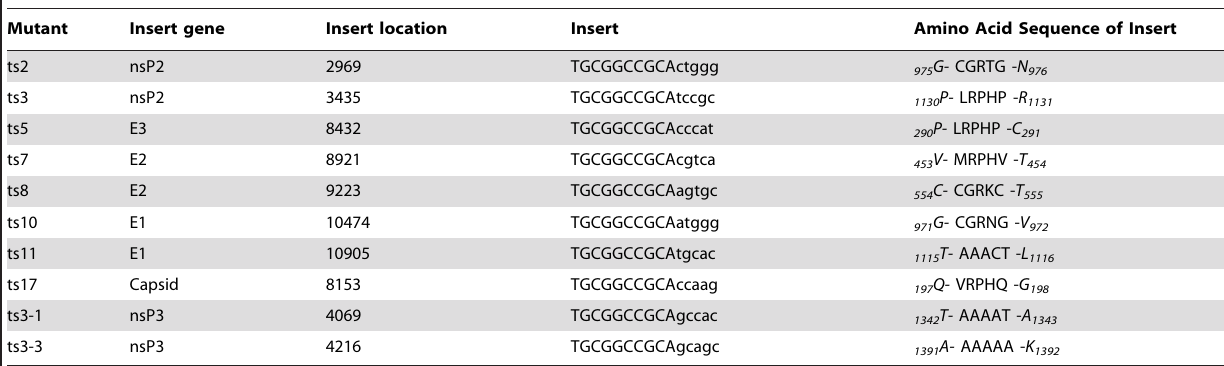
Table 1. Locations of temperature sensitive mutant insertions.